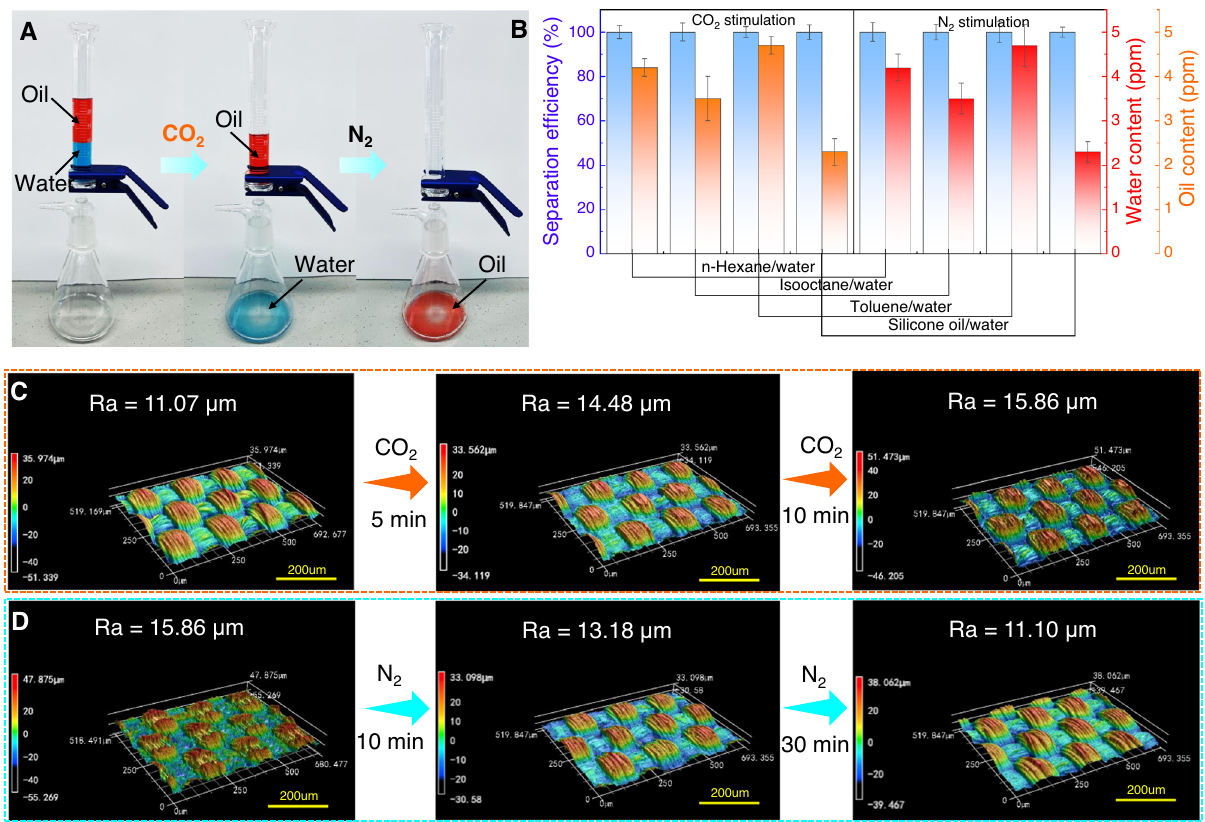
C , D VariationinthesurfaceroughnessofPPFM-0.5underCO 2 /N 2 stimulation.The error bars represent the standard deviation and were calculated on the basis of at least three data points measured from different